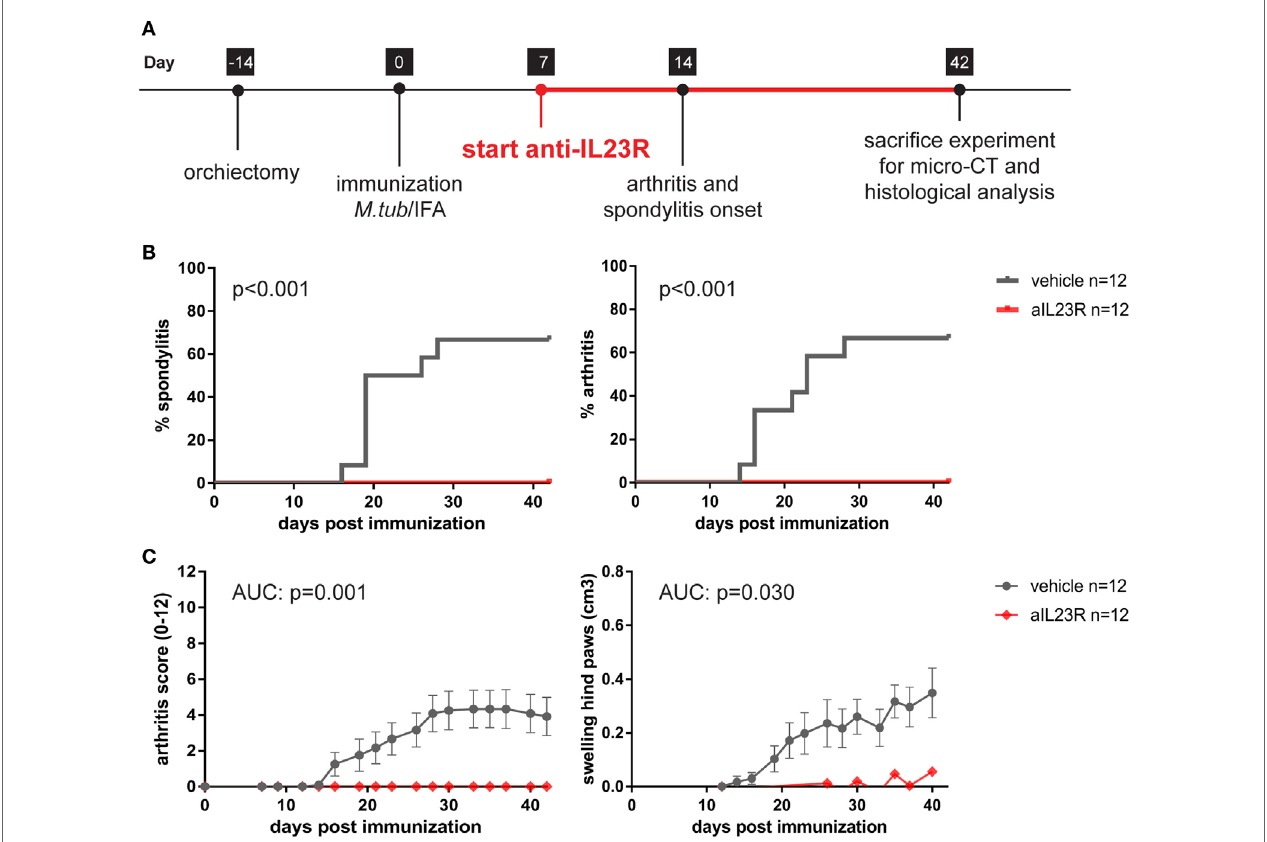
FigUre 1 | Prophylactic treatment with anti-IL23R prevents the development of spondylitis and arthritis. (a) Timeline of the experiment where HLA-B27 tg rats were immunized and prophylactically treated with anti-IL23R or vehicle for 5 weeks ( n = 12 per group). (B) Spondylitis and arthritis incidence (survival analysis). (c) Arthritis severity as measured by arthritis score and swelling of the hind paws (data are mean ±